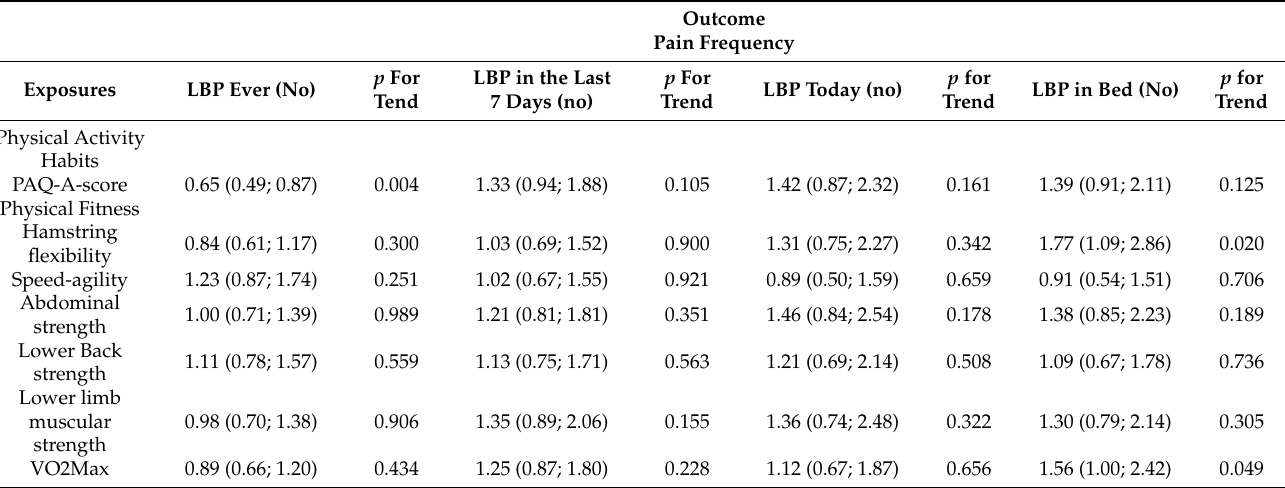
Table 3. Odds ratio of physical fitness according to low back pain